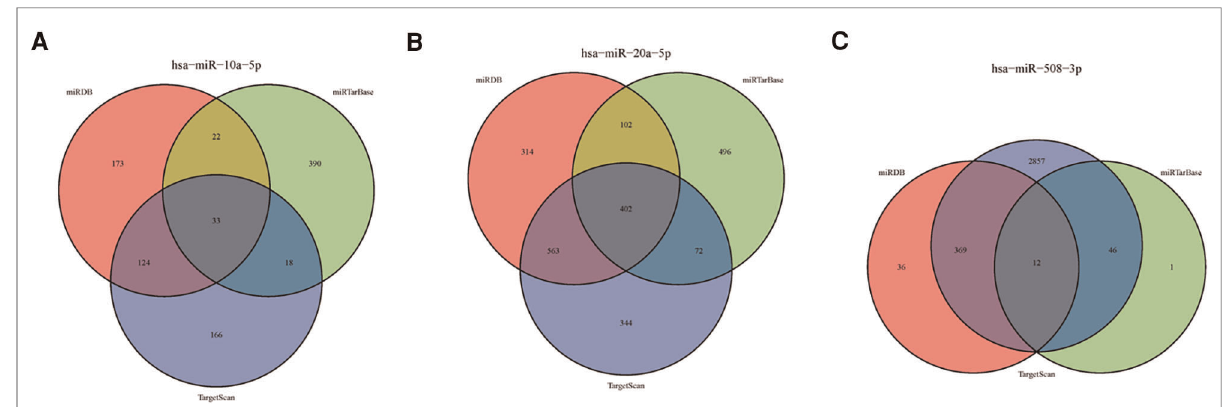
FIGURE 6 Target genes of the sDMIRs. Venn diagrams showing the target genes of the sDMIRs predicted from TargetScan, miRDB, and miRTarBase: ( A) hsa- miR-10a-5p, ( B ) hsa-miR-20a-5p, and ( C )